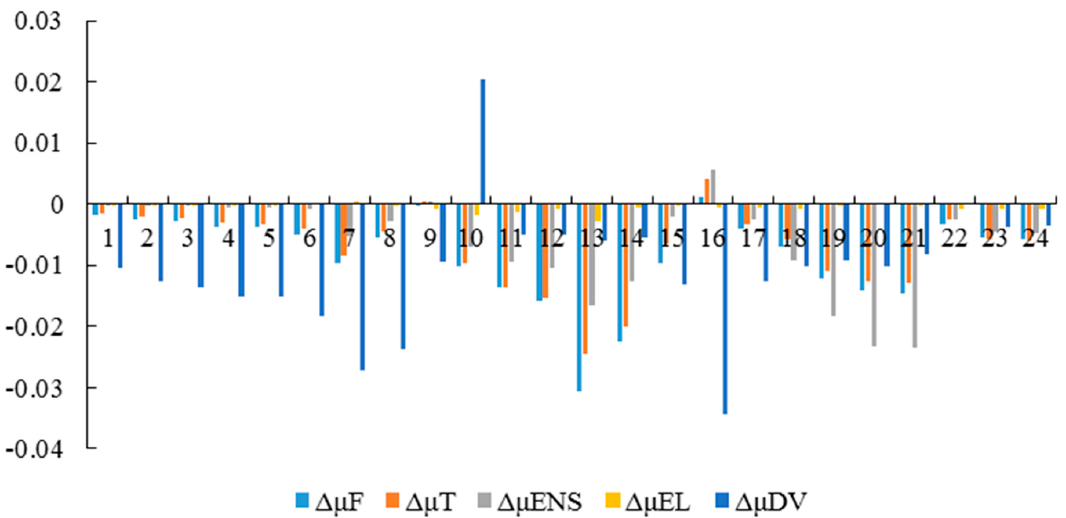
Figure 5. Enhancement in fuzzy membership functions by using network reconfiguration.